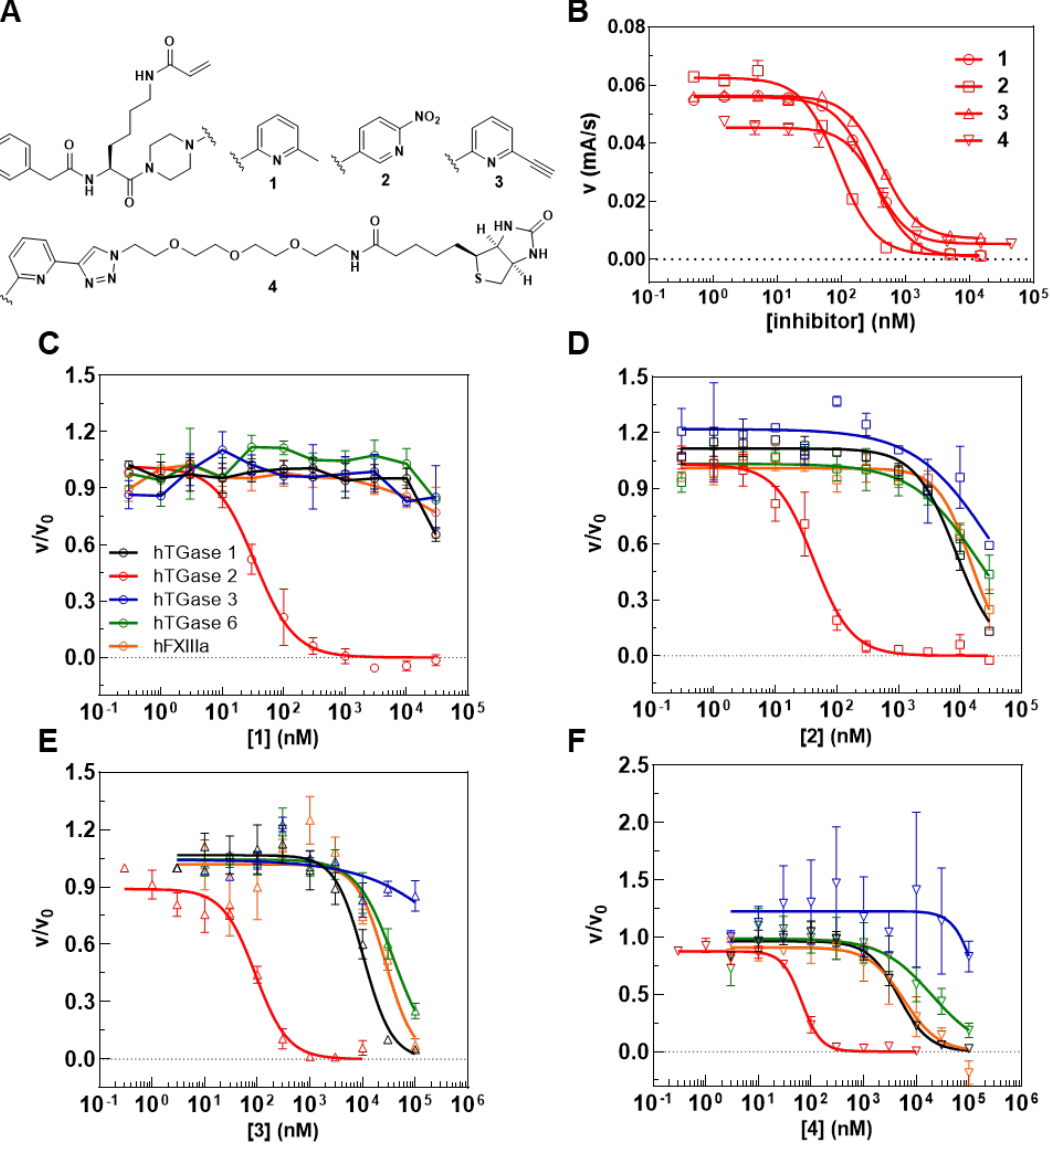
Figure 5. Structures of the inhibitors 1–4 ( A ) and their inhibitory potentials towards different transglutaminases ( B – F ). ( B ) Plots of rate versus inhibitor concentration with nonlinear regression using equation III for the reaction of DMC (30 µM) with R-I-Cad (0.81 µM) in the presence of hTGase 2 (2 µg/mL) using a preincubation period of 5 min for hTGase 2 and inhibitor. Plots of relative rate versus inhibitor concentration for 1 ( C ), 2 ( D ), 3 ( E ), and 4 ( F ) with nonlinear regressions using Equation (3) (but connecting data points for 1 toward hTGases 1, 3, 6 and hFXIIIa) for the reaction of DMC (30 µM) with R-I-Cad (0.74 µM) in the presence of different hTGases (2 µg/mL for hTGase 1; 5 µg/mL for hTGases 2, 3, 6 and hFXIIIa) using a preincubation period of 30 min for hTGases and inhibitor. Data shown are mean values ± SEM of 3 separate experiments, each performed in dupli- cate. Conditions: pH 8.0, 30°C, 5% DMSO, 500 µM DTT or TCEP (hTGase 2). Data for inhibitors 1 and 2 shown in B were published previously [54].